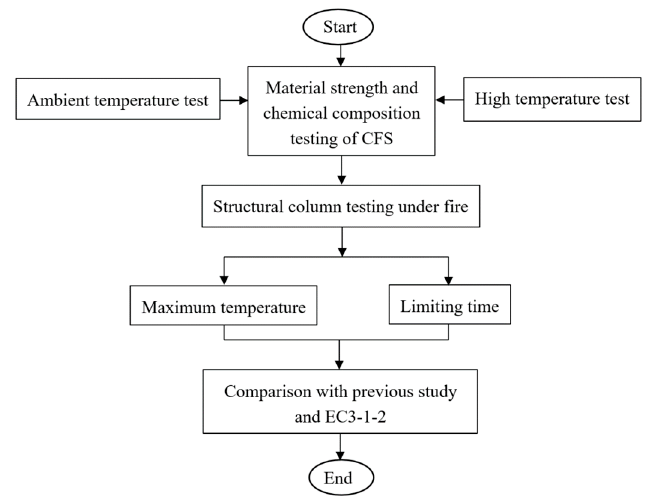
Figure 6. The methodology of the research.